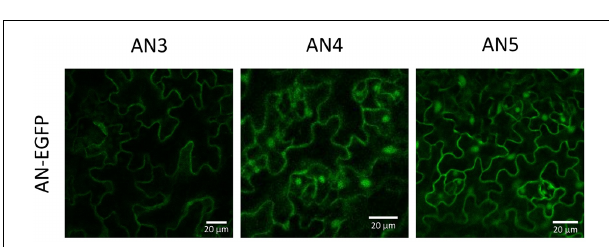
FIGURE 2 | Localization of ArathNictaba-EGFP fusion constructs expressed in stably transformed Arabidopsis thaliana plants. Localization is shown in the lower epidermis cells of the leaves. All images are a compilation of different fluorescent images acquired along the z